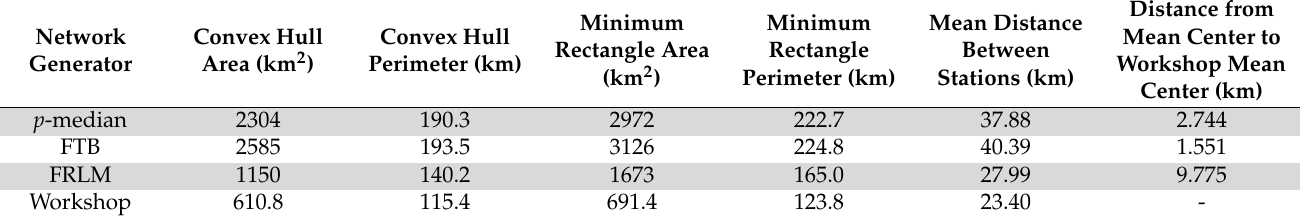
Table 11. Point pattern analysis metrics for 8 stations ( p =